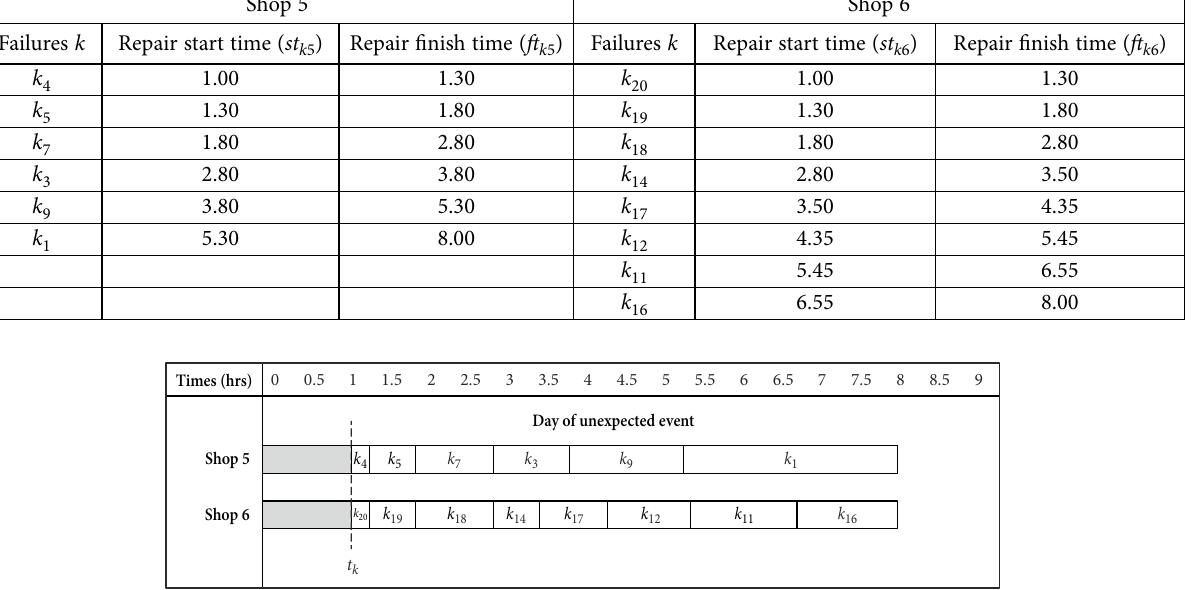
Figure 8. Sequencing the scheduled emergent failures in shop 5 and shop 6